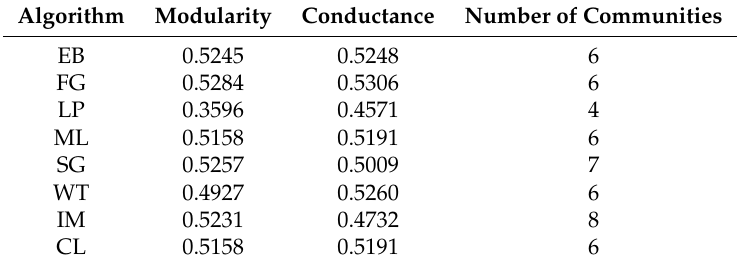
Table 2. Evaluation of the solution generated by each algorithm over the example graph using the three considered